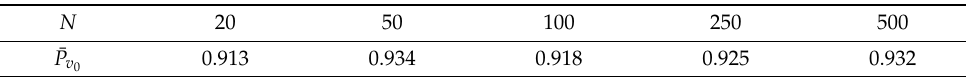
Table 1. The average inclusion probabilities of vertices in the same block as the seed for different network sizes. N is the number of vertices in the same block as the seed. The total number of vertices in the network is thus 2 N .